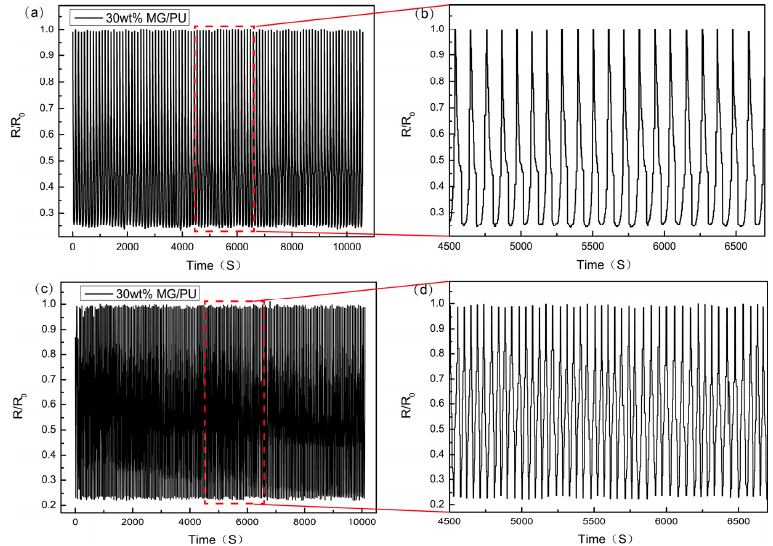
Figure 9. ( a , c ) The dynamic resistivity variation of 30 wt % MG/PU film under cyclic loading/unloading with different speed rates of 10 mm/min ( a ), 20 mm/min ( b ) and the pressure of 64 KPa. ( b , d ) Enlarged views of the selected area in Figure 9a,c